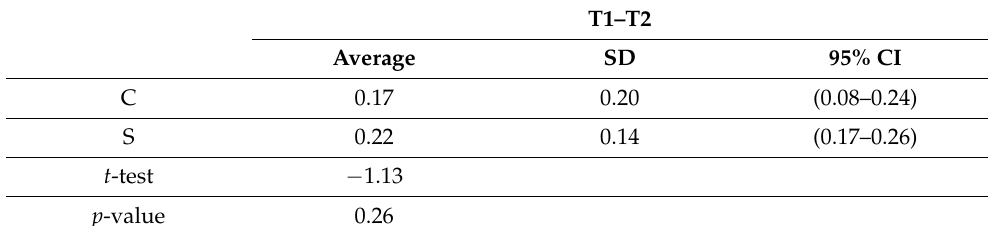
Table 4. Bone loss in crestal and subcrestal implants.